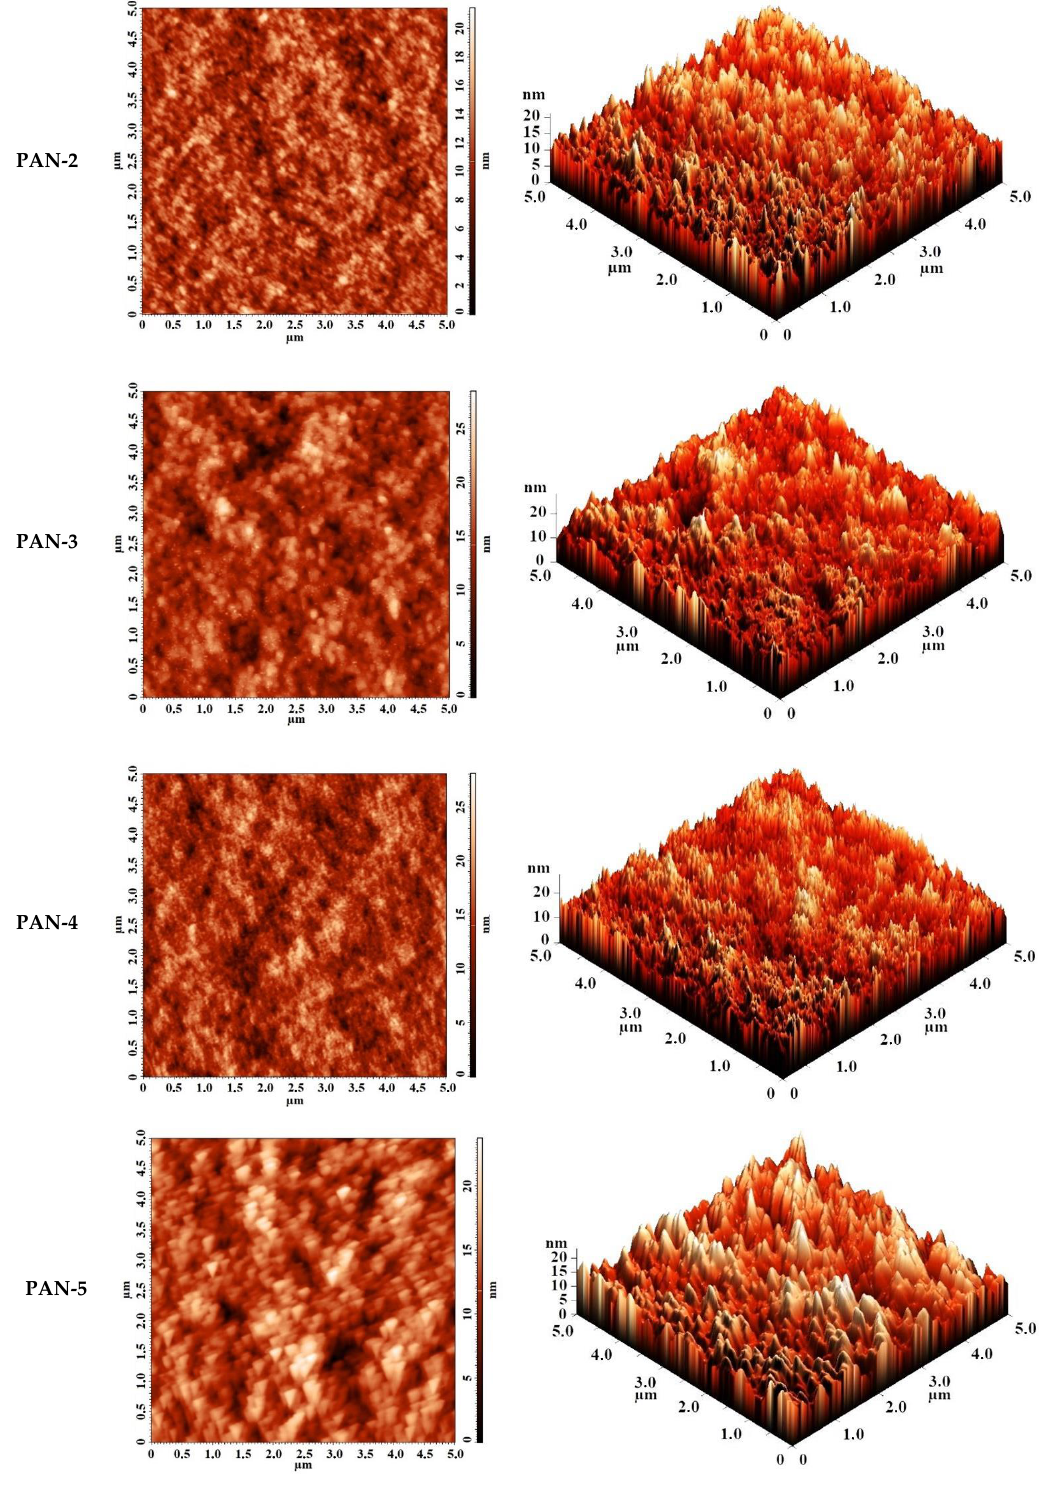
Figure 5. AFM images of the surfaces of the selective layers of porous PAN membranes (substrate). The roughness characteristics (root-mean-square roughness (Rq) and average surface roughness (Ra)) of ultrafiltration PAN-2,3,4,5 membranes were calculated based on the obtained AFM images and presented in Table 1. Table 1. Roughness characteristics and water contact angles for porous PAN membranes (substrates). The mean accuracy was <±2% for roughness characteristics and ±2° for contact angle. Membrane Ra, nm Rq, nm Water Contact Angle,° PAN-2